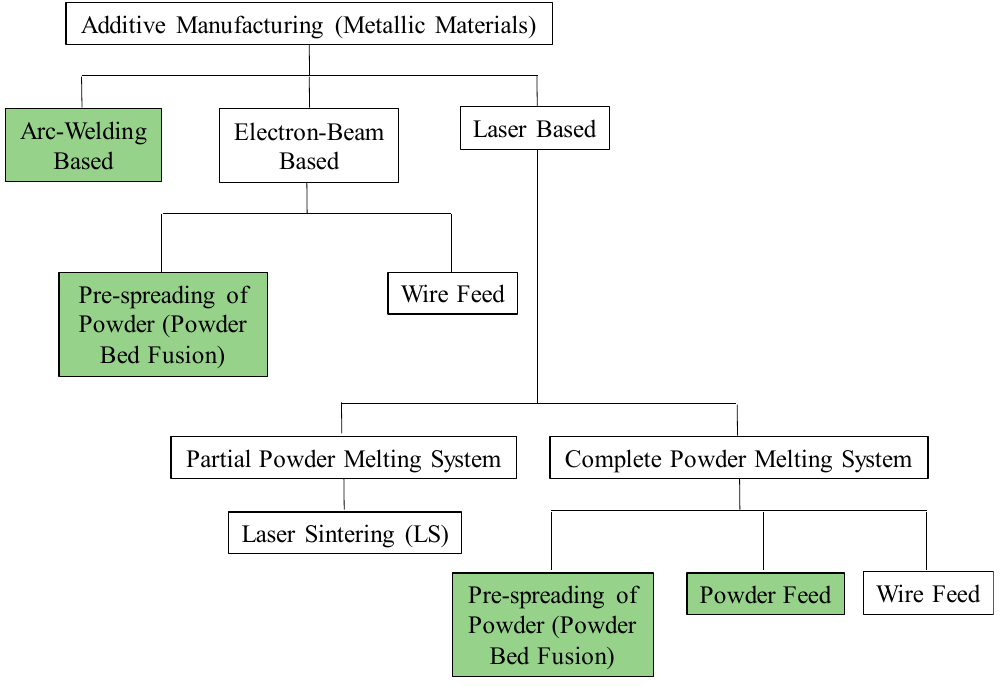
Figure 10. Classification of AM processes. Green boxes represent the AM processes that have shown success in repairing simple geometry SX components to date.